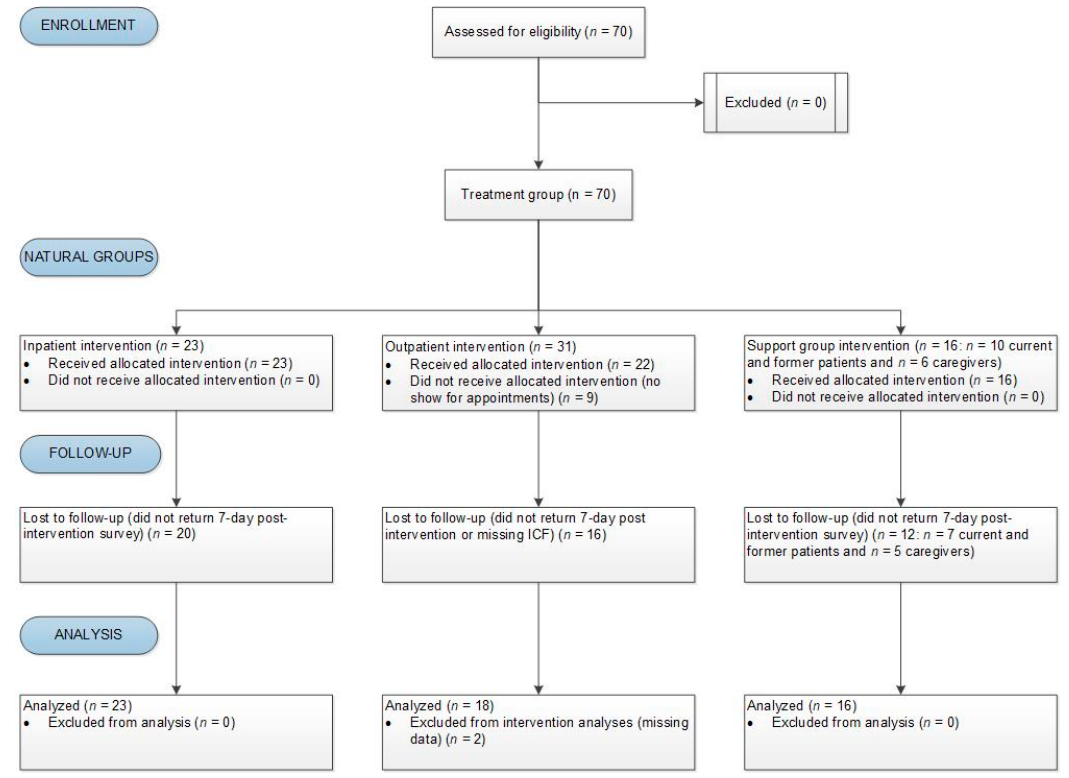
Figure 1. CONSORT patient stratification